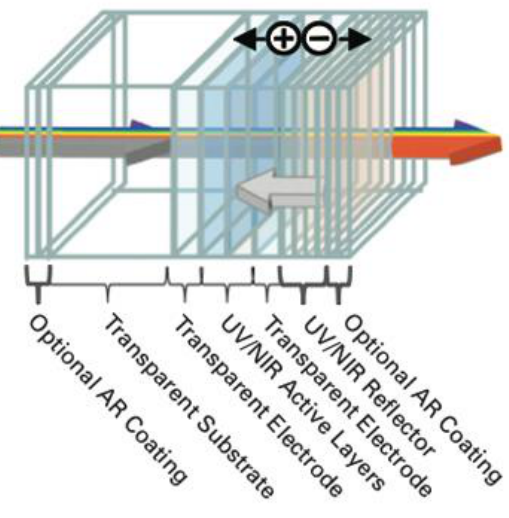
Figure 7. Transparent solar panel